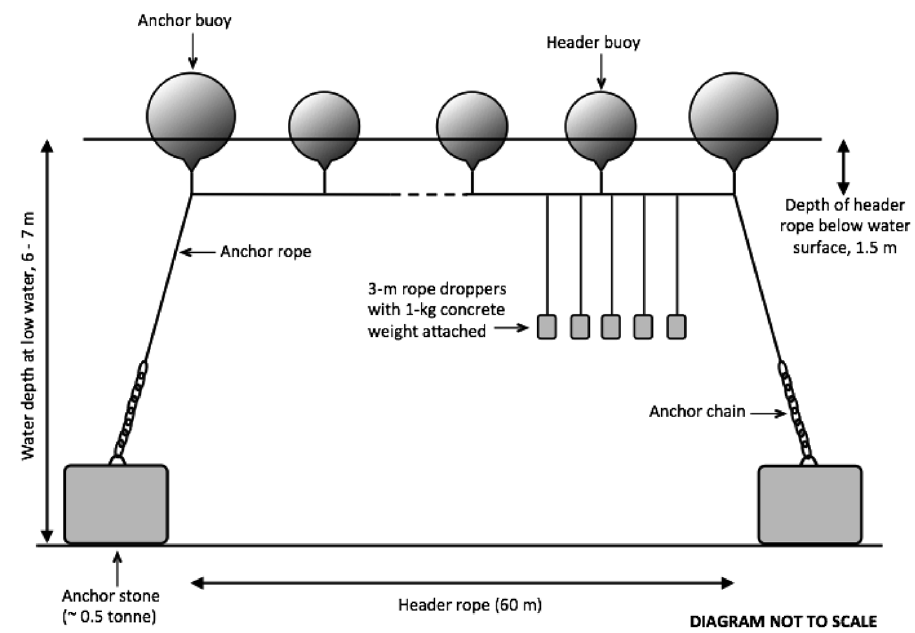
Fig. 3. Schematic of suspended longline structure in Ard